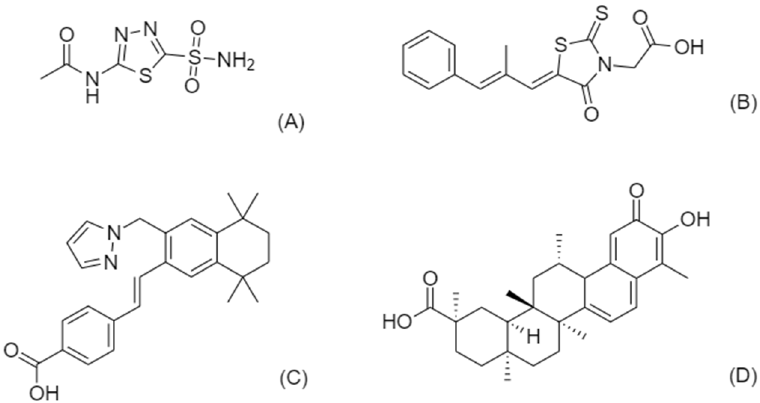
Figure 1. Chemical structures of CDG-repositioned drugs in clinical pipelines. ( A ) acetazolamide, ( B ) epalrestat, ( C ) palovarotene, and ( D ) celastrol.